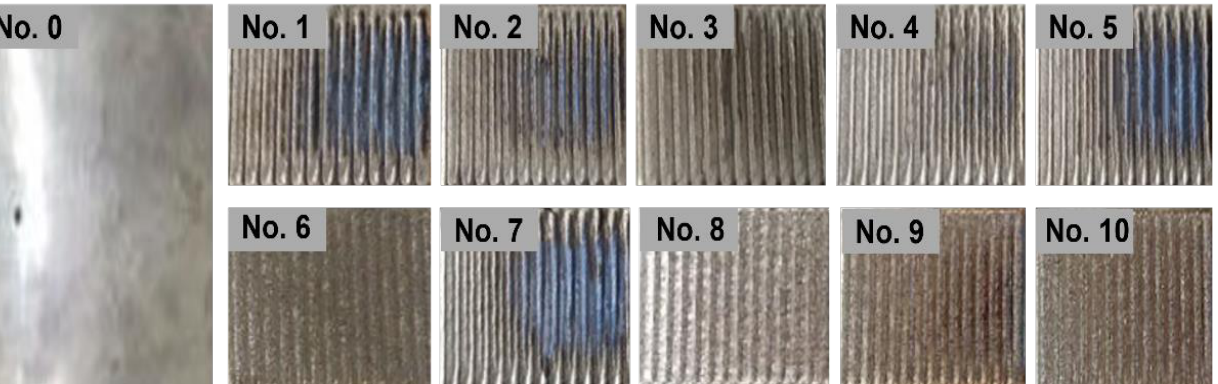
Figure 2. Laser clad coatings and the 316L stainless steel substrate. Table 3. Mass ratio of mixed powder and laser processing parameters. Specimen Number